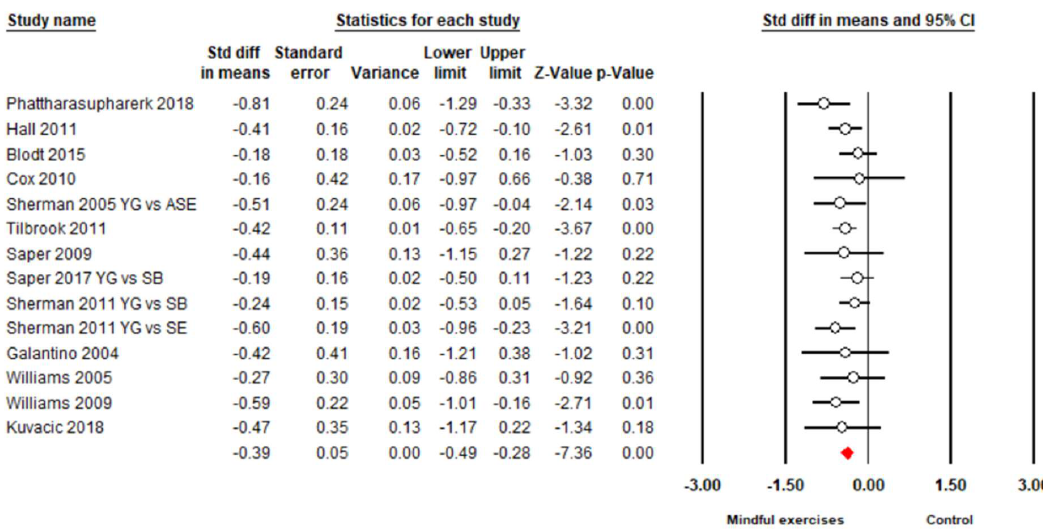
Figure 5. The effect of mindful exercises on disability (YG = Yoga, ASE = Aerobic and strength exercise, SB = self-care book, SE = stretching exercise).The red symbol below represents the overall effect size in favor of mindful exercises.